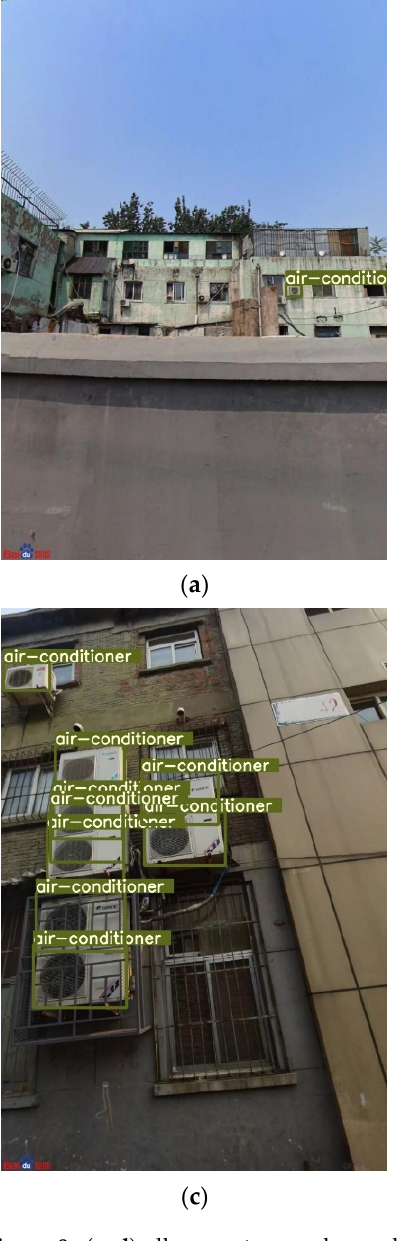
Figure 8. ( a – d ) all present several sample images of misidentified entities during the predicting process; ( a , b ) present several small unidentified external air conditioner units and phenomenon of lacking labeling; ( c , d ) present a phenomenon of excessive and incorrect labeling.